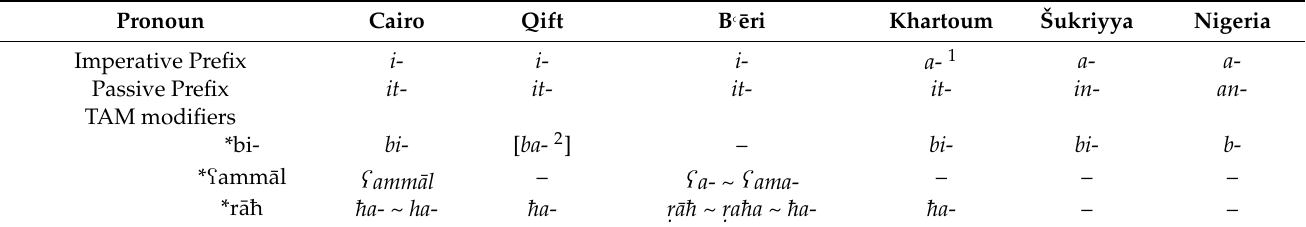
Table 7. Tense, Aspect, Mood and Voice